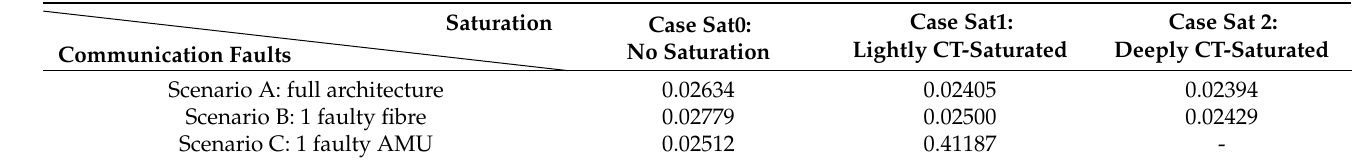
Table 8. Trip signals obtained for CT saturation tests for all types of faults